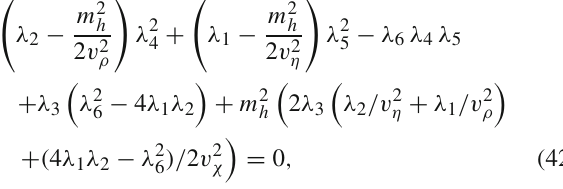
Fig. 7 The region separating ellipses and hyperbolas for a λ 3 fixed and λ 6